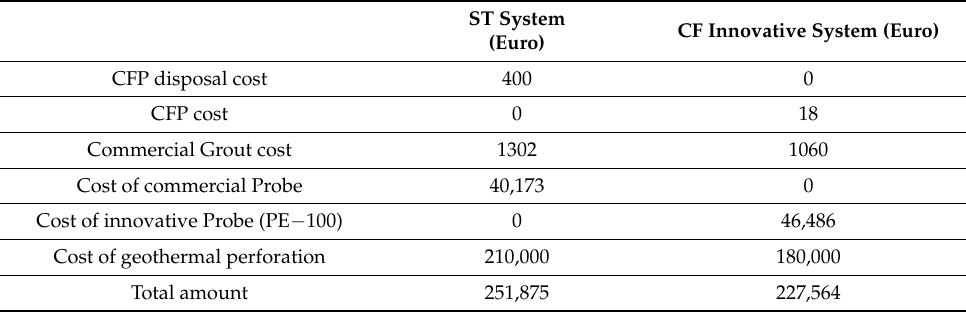
Table 8. Global economy